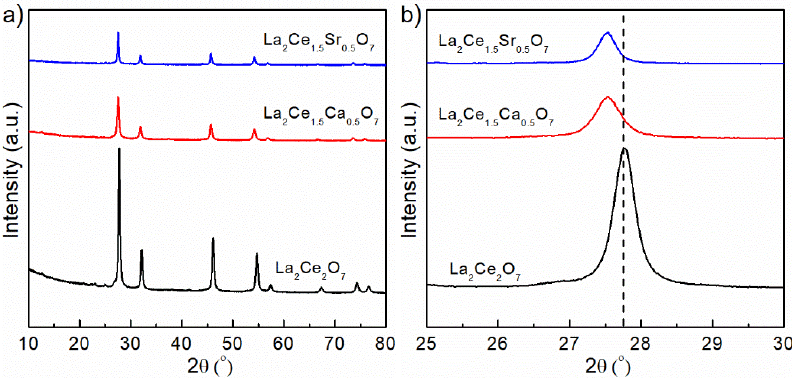
Table 6. H 2 -TPR results of the catalysts.